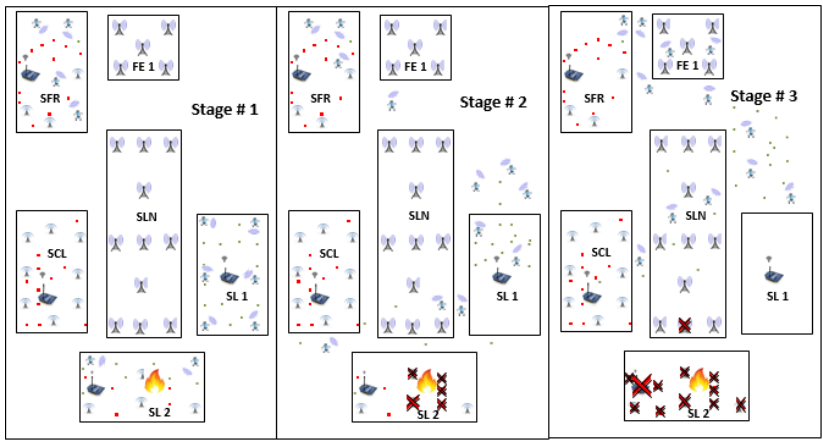
Figure 6. Scenario 2: Smart Lab 2 (SL-2) is Being Affected by Fire Disaster in a Smart